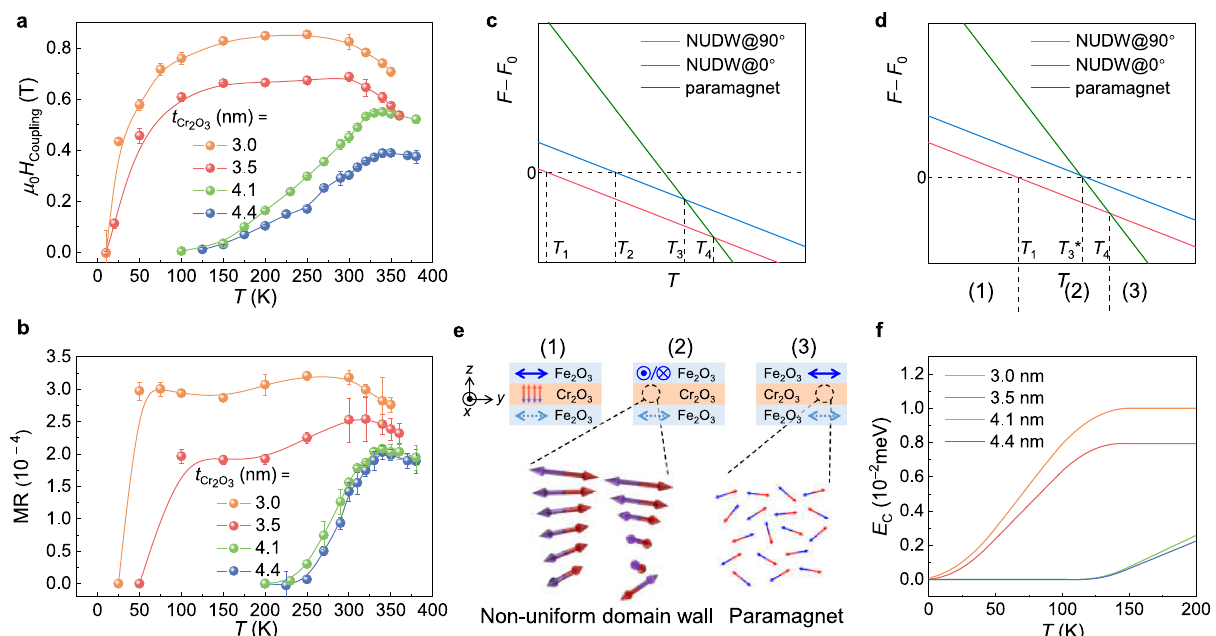
Fig. 5 Temperature and spacer thickness dependent interlayer coupling. a Summary of the location ( μ 0 H Coupling ) of the fi rst peak for Fe 2 O 3 /Cr 2 O 3 / Fe 2 O 3 /Pt samples with various Cr 2 O 3 layer thicknesses ( t = 3.0, 3.5, 4.1, and 4.4 nm). b Corresponding summary of the temperature-dependent magnetoresistance (MR). The error bars are estimated from the SMR data with sweeping H four times. c , d Schematic free energy diagrams for the thin Cr 2 O 3 ( c ) and the thick Cr 2 O 3 ( d ) cases. e Magnetic order in Fe 2 O 3 /Cr 2 O 3 /Fe 2 O 3 at three temperature ranges (1) – (3) as marked in d . f Temperature dependence of calculated coupling